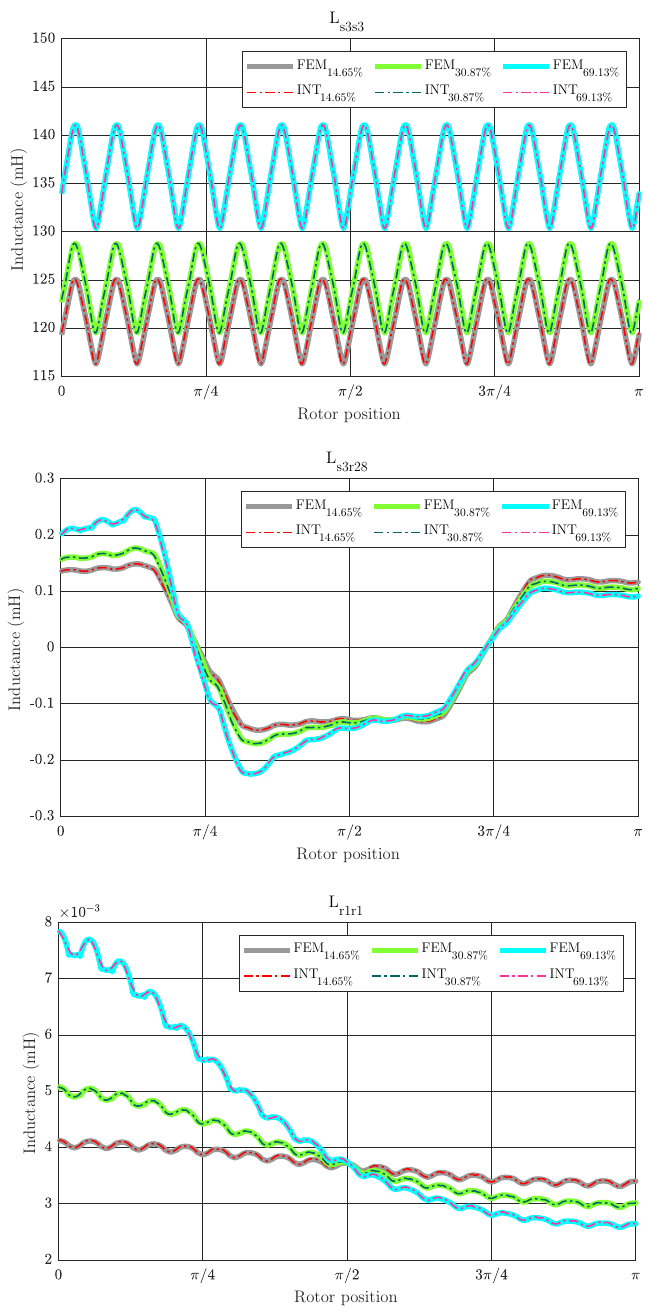
Figure 4. Coupling parameters between stator phase 3 and itself, between stator phase 3 and rotor bar 28 and between rotor bar 1 and itself depending on the rotor position using FEM simulations (FEM) and the proposed method (INT), for three different degrees of static eccentricity fault. The proposed method obtains mostly the same values as FEM. Table 3. Computational costs, computational time and memory resources to obtain the coupling pa- rameters of a faulty IM for a generic case, a case of static eccentricity and using the proposed